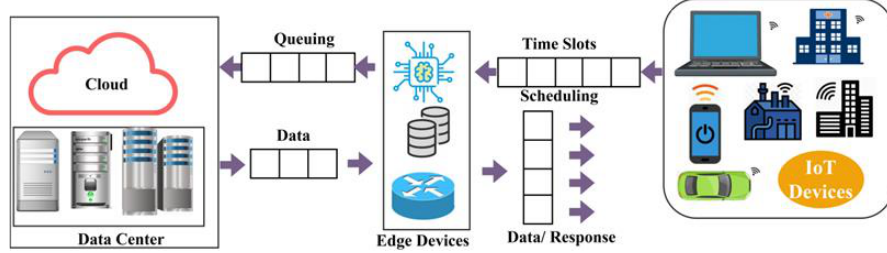
Figure 1. DTS-EC in IoT-Edge Environment.